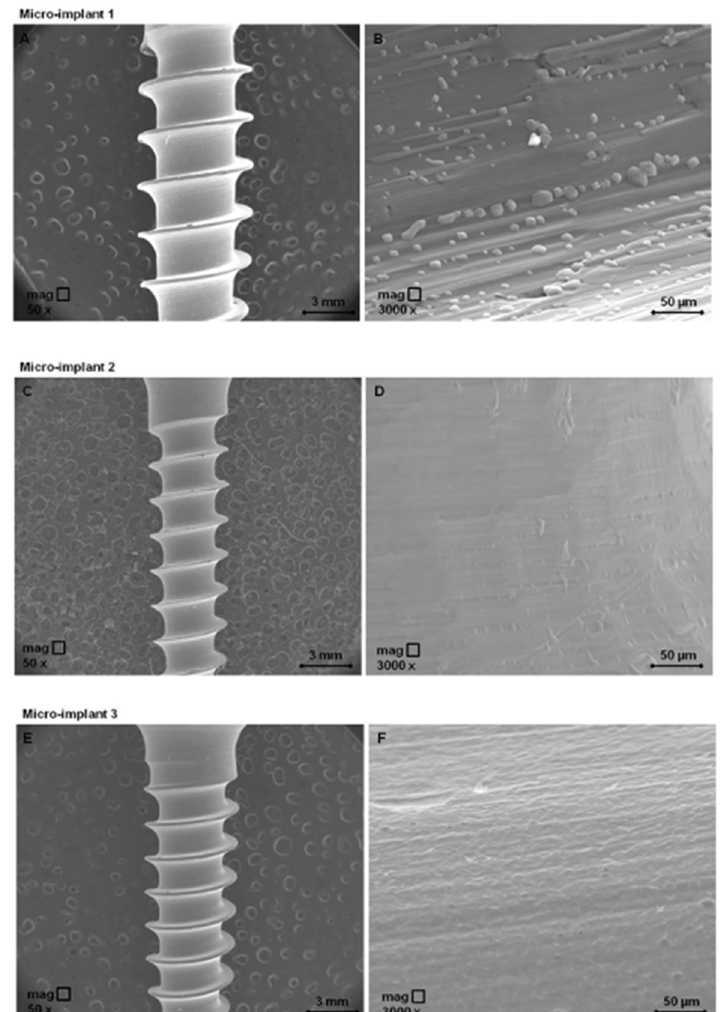
Figure 2. Scanning electron microscopy micrographs of test orthodontic implants at two different magnification orders. Pictures ( A , C , E ) show the general overview of the test orthodontic implants—P1, P2, P3, respectively by employing an enlargement of 50 × ; Pictures ( B , D , F ) show the surfaces’ detail topography of the test orthodontic implants P1, P2, P3, respectively by employing 3000 × magnification.